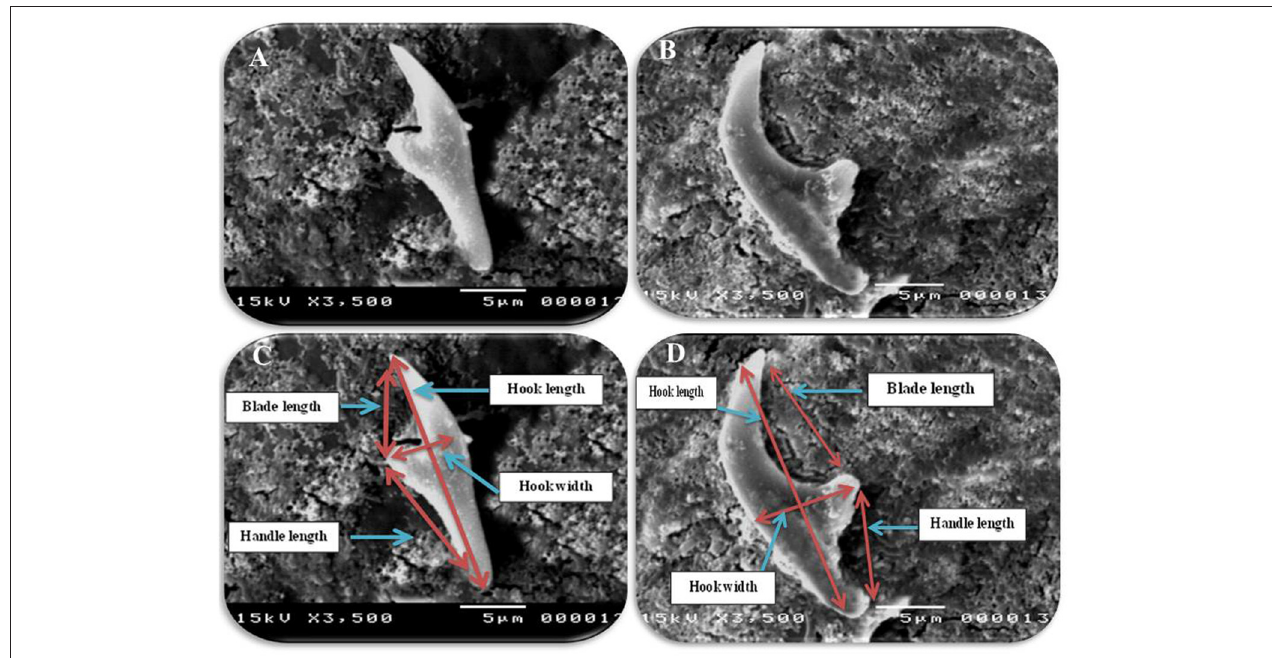
FIGURE 4 | Morphometric appearance of small and large hook of hydatid cyst isolated from cattle lung using SEM. (A) The small hook of hydatid cyst isolated from cattle lung. (B) The large hook of hydatid cyst isolated from cattle lung. (C) Measurement the small hook of hydatid cyst isolated from cattle lung; Total hook length = 22 µ m (arrow), total hook width = 6 µ m (arrow), handle length = 10 µ m (arrow) and blade length = 5 µ m (arrow) and (D) measurement the large hook of hydatid cyst isolated from cattle lung; total hook length = 28 µ m (arrow), total hook width = 8 µ m (arrow), handle length = 8 µ m (arrow) and blade length = 16 µ m (arrow).